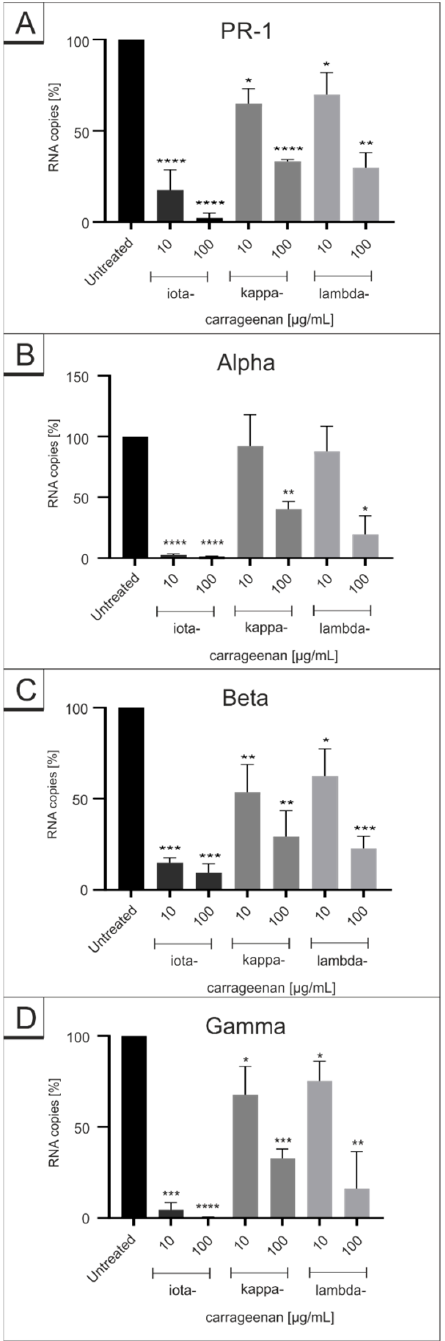
Figure 3. Comparison of the influence of iota-, lambda- and kappa-carrageenan on the replication of SARS-CoV-2 wt and its VOCs. Calu-3 were infected with SARS-CoV-2 PR-1 , Alpha, Beta or Gamma at a MOI of 2 × 10 − 2 . At 1 h post infection, input virus was removed, and cells were treated with the indicated concentrations of iota-, kappa- and lambda-carrageenan. Cell culture supernatants were harvested at 3 days post infection (dpi). The virions were purified and analyzed by q-RT-PCR. Data represent means of 6 ( A iota-carrageenan), 4 ( C + D kappa- and lambda-carrageenan) and 3 ( A + B kappa- and lambda-carrageenan, B + C + D iota-carrageenan) independent experiments ± standard deviation (* p < 0.5, ** p < 0.01, *** p < 0.001, and **** p < 0.0001) using a one sample t test, where each value is compared to the untreated control. The absolute values of conducted qRT-PCR analysis are included in Supplementary Table